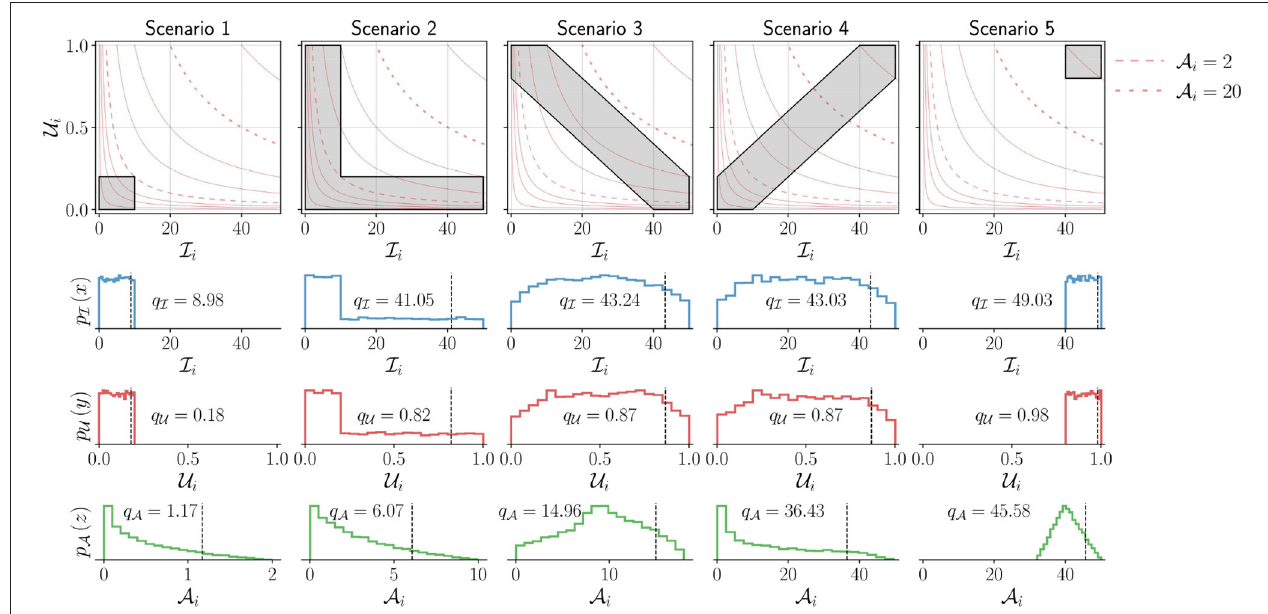
FIGURE 5 | Demonstration of the measure H q for five different simulated scenarios corresponding to different levels of upper-limb activity. The top row shows the UI plot for the different scenarios. The shaded areas (gray) indicate different simulated scenarios from which points are sampled with uniform density. Two of constant activity lines (light red) in each plot are shown as dashed lines corresponding to A i = 2 and A i = 20. The bottom three rows depict the marginal probability density functions for I i (second row), U i (third row), and A i (bottom row) for these different scenarios. The black vertical dashed line indicates the q th percentile (here, q = 90) for these different scenarios with the corresponding value written on the individual plots. Note that to enable the proper depiction of the density functions for the different scenarios, the scale for the x axis for the bottom row is